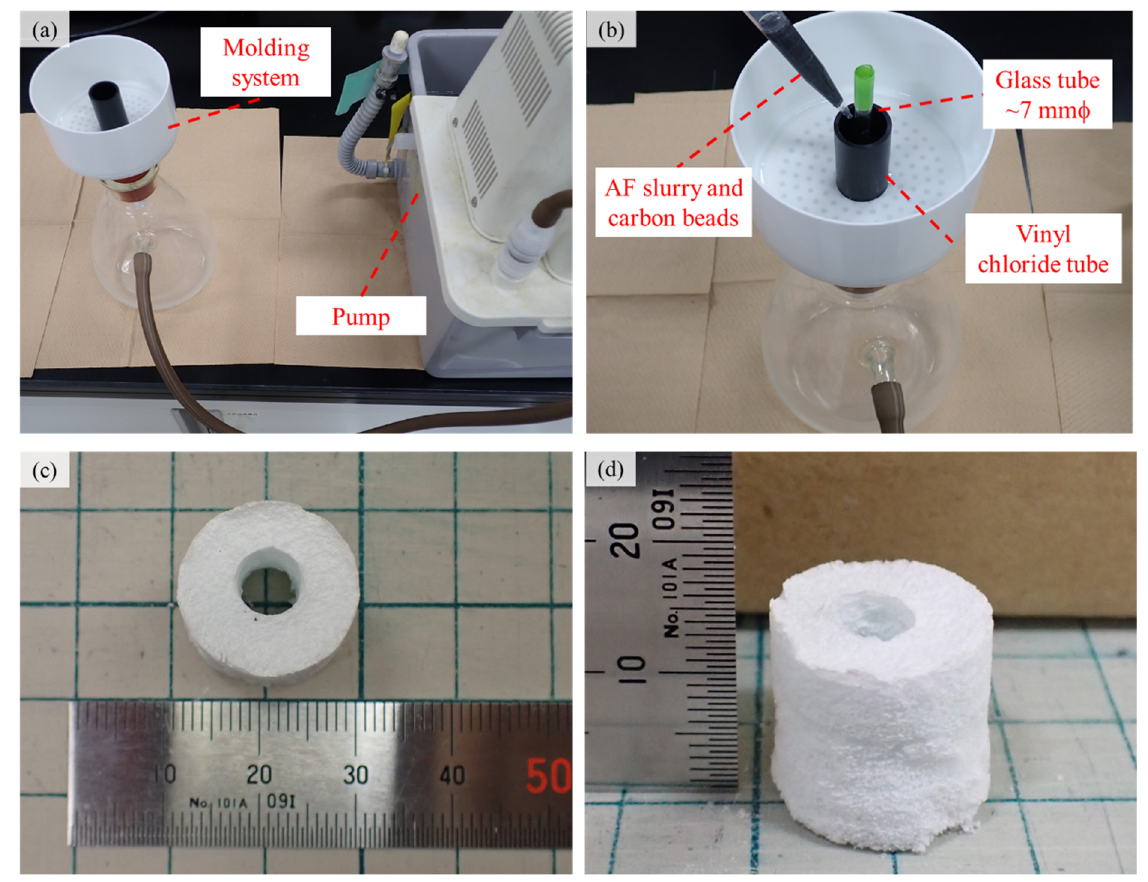
Figure 6. Modeling system for AFS2000. ( a ) Overview and ( b ) detailed view and photographs of AFS2000. ( c ) Top and ( d ) side views.